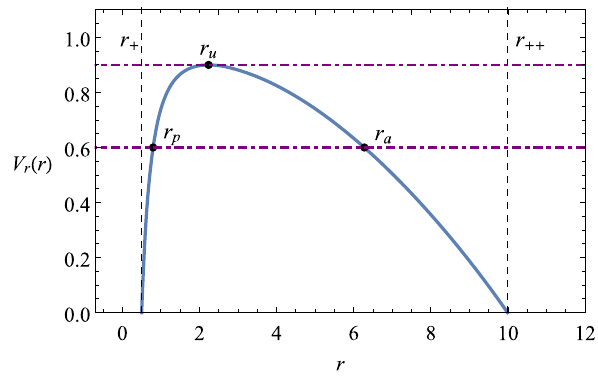
Fig. 11 The effectivepotentialforradialtrajectoriesplottedfor Q = 1 and λ = 10. The radial distances r u , r p and r a have been